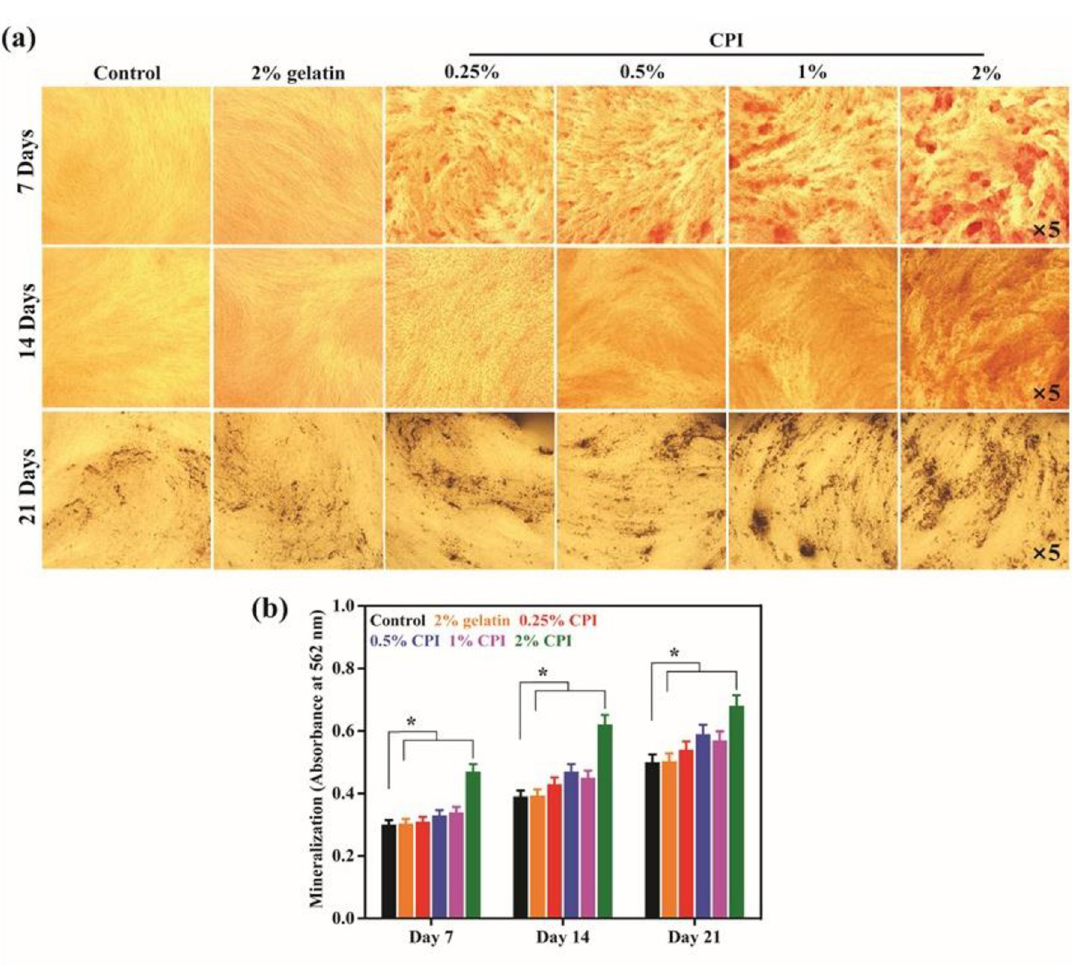
Fig 6. Evaluation of in vitro osteoblast differentiation in the presence of CPI. (a) ARS staining of CPI-treated hBMSCs after 7 and 14 days of incubation, and (b) corresponding quantitative values at indicated time intervals. Data are mean ± SD of triplicated experiments, statistical significance at � p < 0.05. The black arrow indicates the presence of stained CPI on the surface of hBMSCs.